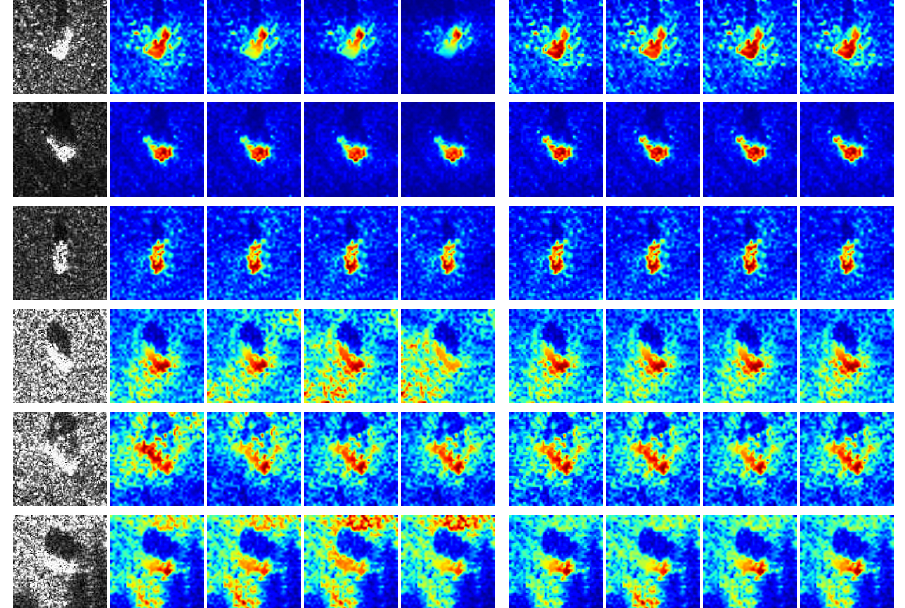
Figure 7. Saliency heatmaps generated by G-SM-CAM and SC-SM CAM with different G . The first columns are original SAR images. The second to the fifth columns are generated by G-SM-CAM when G = 4, 8, 16, 32. The sixth to the ninth columns are generated by SC-SM CAM when G = 4, 8, 16, 32.